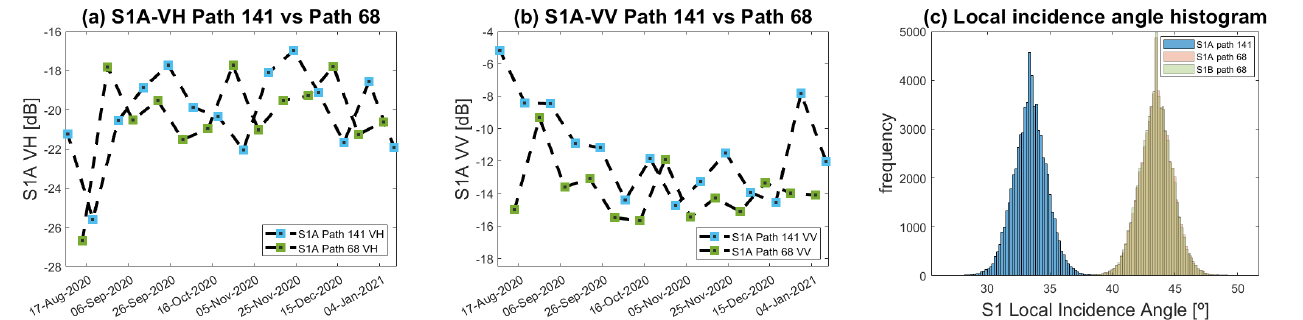
Figure 5. S1-A acquisition trends over the study site. ( a ) Time-series of S1-A VH polarization data for path 141 against path 68. ( b ) Time-series of S1-A VV polarization data for path 141 against path 68. ( c ) S1 Local incidence angle histograms.